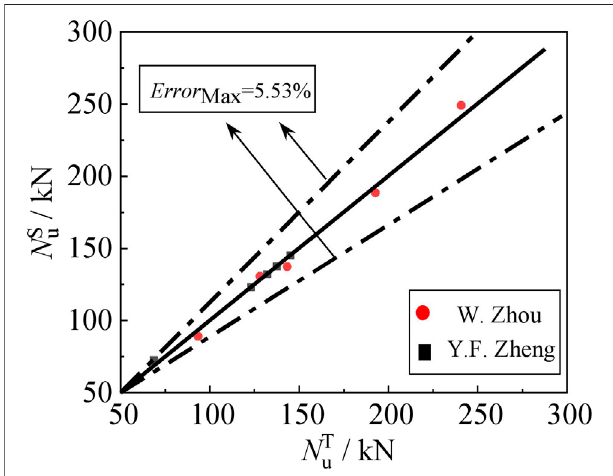
FIGURE 7 | Comparison between N s u and N T u for ten specimens.